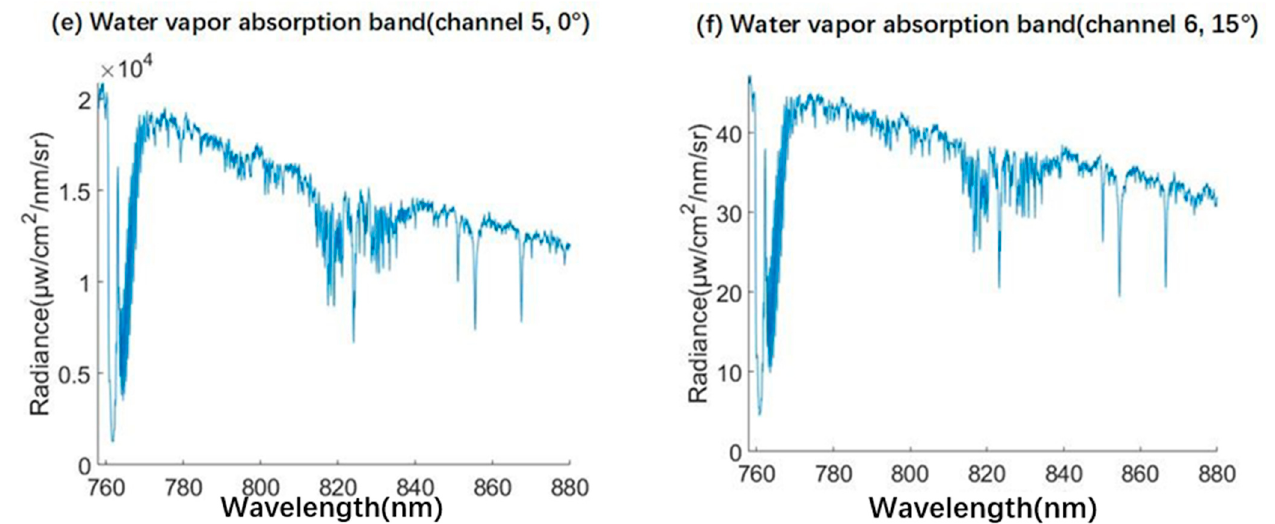
Figure 28. The diagram of converting the measured DN value of the external field in the molecular oxygen A ‐ band (1, 2, 3 channels) and the water vapor absorption band (4, 5, 6 channels) to the radiation value.